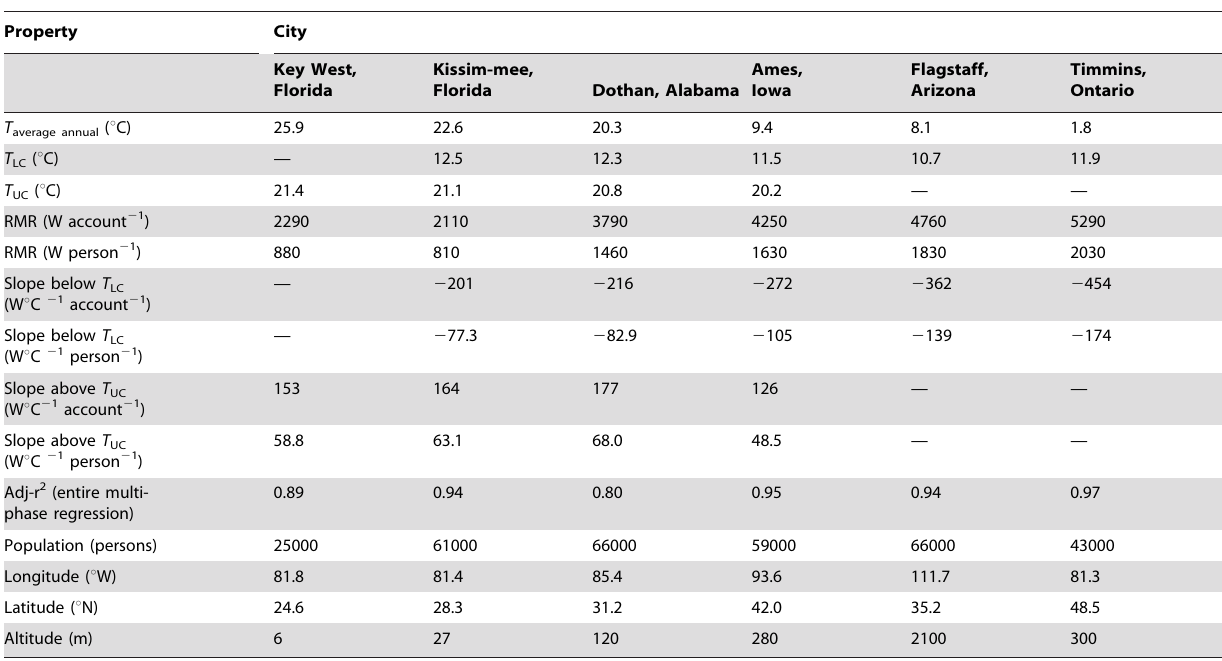
Table 1. Statistical results for the six cities, listed (left to right) from highest to lowest average annual temperature.